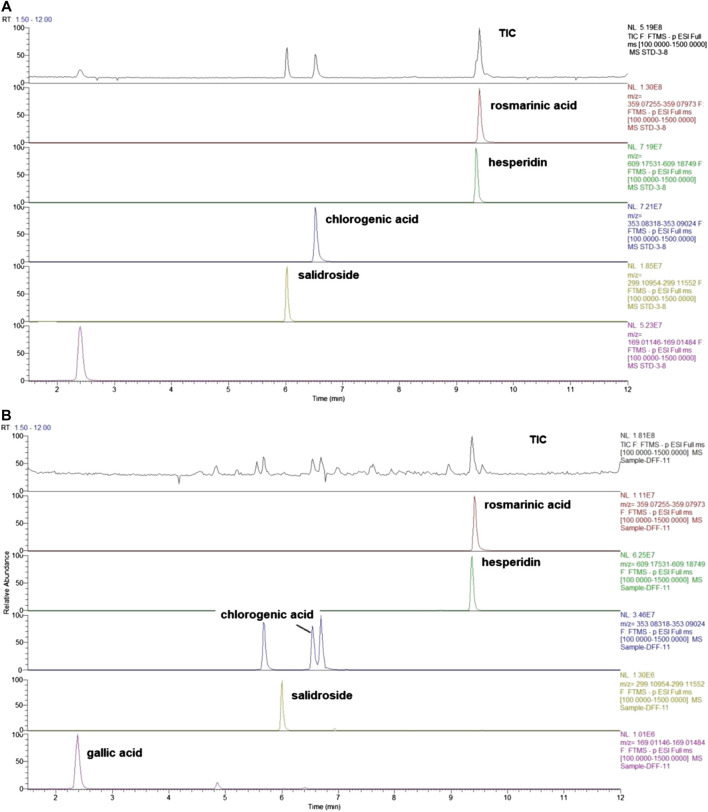
Total-ion chromatograms of standard and sample by UHPLC- Q/Exactive. (A) The mix standard solution. (B) The chromatographic profile of WCAF extracts [Stationary phase: Waters Acquity HSS T3 (100 × 2.1 mm, 1.8 μm); mobile phase: aqueous 0.1% formic acid (I) and acetonitrile (II) (0–2 min, 2%II; 2–12 min, 2–-45%II)].